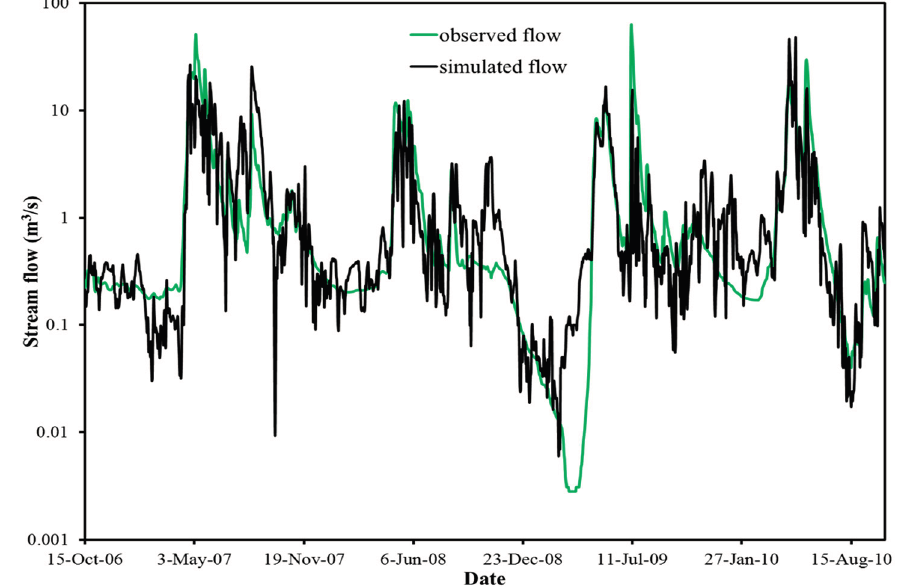
Figure 4. Comparison of observed and simulated stream flows with the Gridded Surface Subsurface Hydrologic Analysis (GSSHA) model at the outlet of the study area during the calibration period.